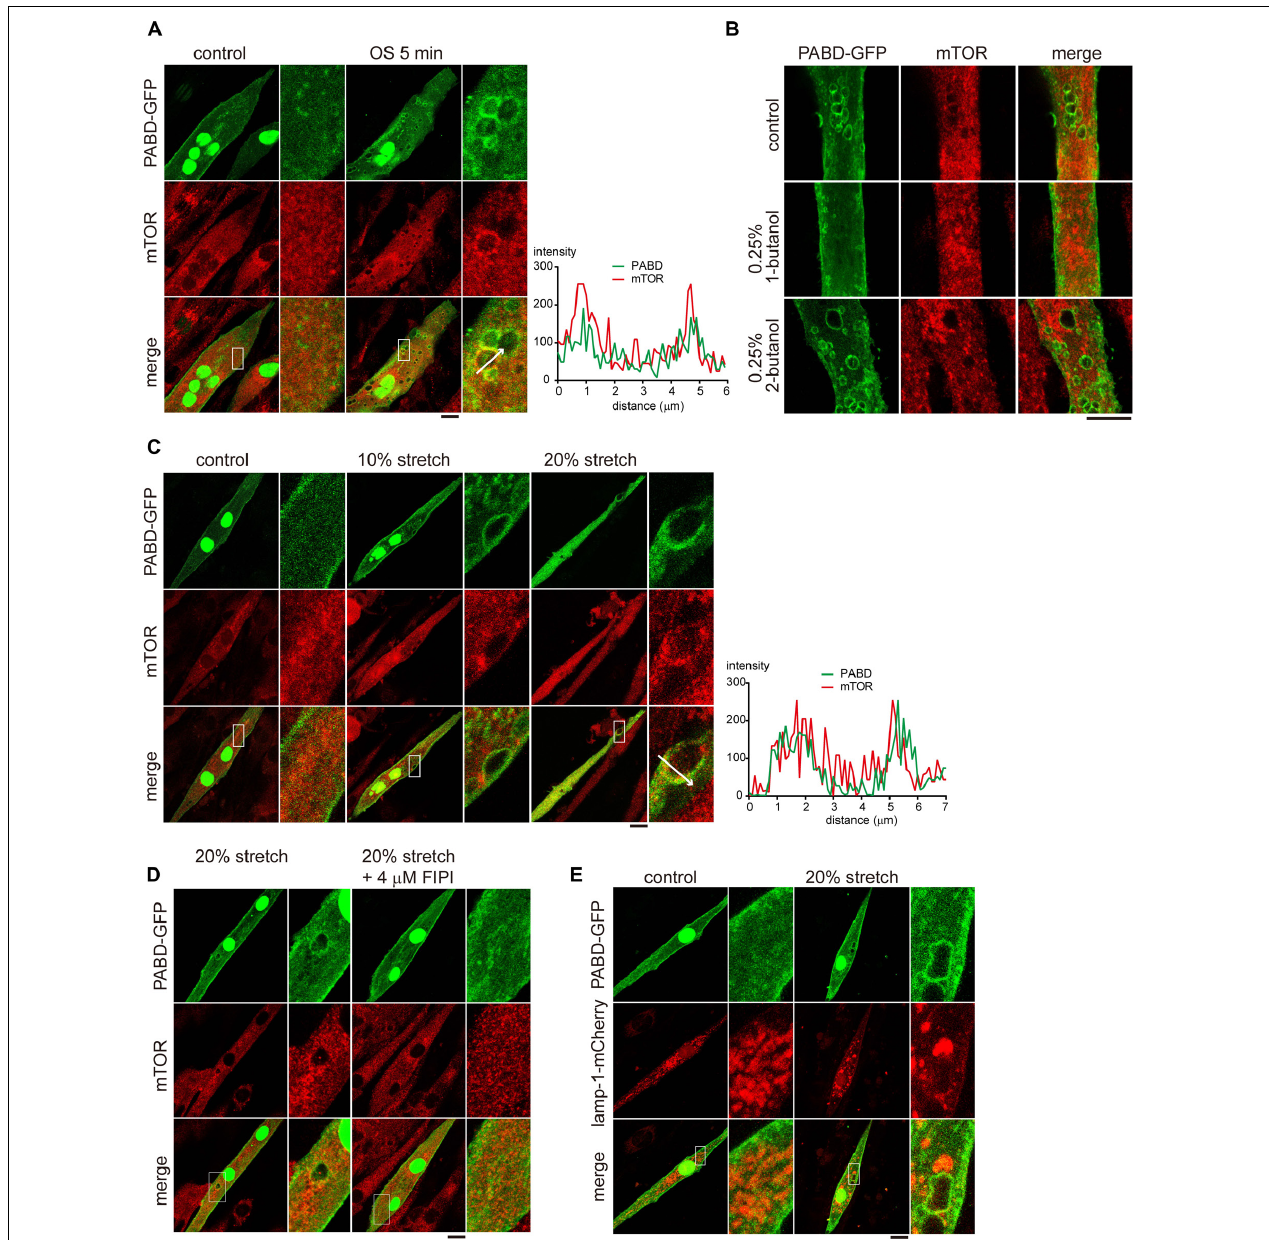
FIGURE 5 | mTOR is localized to the PA-enriched macropinosome. (A) Localization of mTOR in OS-stimulated myotube. PABD-GFP expressing myotubes with or without OS treatment, were immunofluorescence stained to label the endogenous mTOR and were imaged with confocal microscopy. Boxed areas were magnified and shown on the right panel. The fluorescence intensity profiles from the line scan are shown to illustrate the co-localization of mTOR and PABD-GFP. (B) 1-Butanol inhibits the targeting of mTOR to macropinosome upon OS treatment. PABD-GFP expressing myotubes with 0.25% 1- or 2-butanol pre-incubation were subjected to OS treatment and further stained for endogenous mTOR distribution. (C) Single cycle of mechanical stretching and relaxation leads to mTOR targeting to PA-rich macropinosome. PABD-GFP expressing myotubes cultured on silicon membrane were subjected to 0, 10, or 20% radial stretch for 2 min and followed by 2-min resting. After immunofluorescence staining of endogenous mTOR, cells were imaged with confocal microscopy. (D) FIPI inhibits the formation of mTOR- and PA-enriched macropinosome upon stretching. PABD-GFP expressing myotubes were pre-incubated with DMSO or FIPI and then subjected to single cycle of mechanical stretch and relaxation. After fixation and immunofluorescence staining, the distribution of PABD-GFP and endogenous mTOR were imaged with confocal microsocpy. (E) Mechanical stimulation-induced PA is not enriched at lysosome. After single cycle of 20% stretch, PABD-GFP and Lamp1-mCherry expressing myotubes were fixed and imaged with confocal microscopy. Scale bars: 10 µ